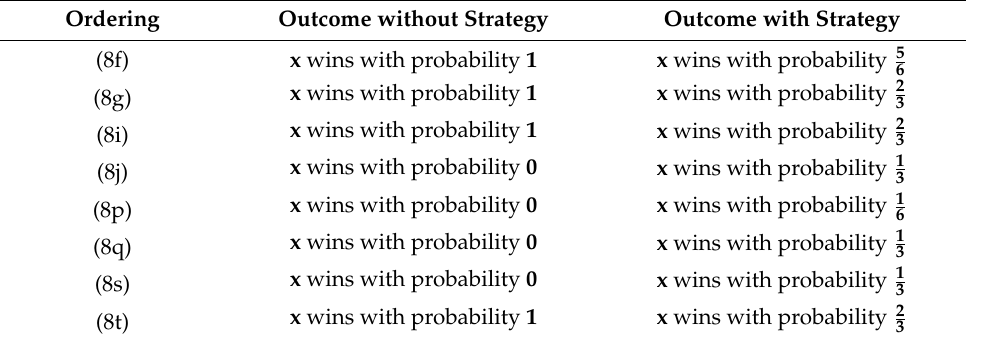
Table 4. Representation Game Nash equilibrium